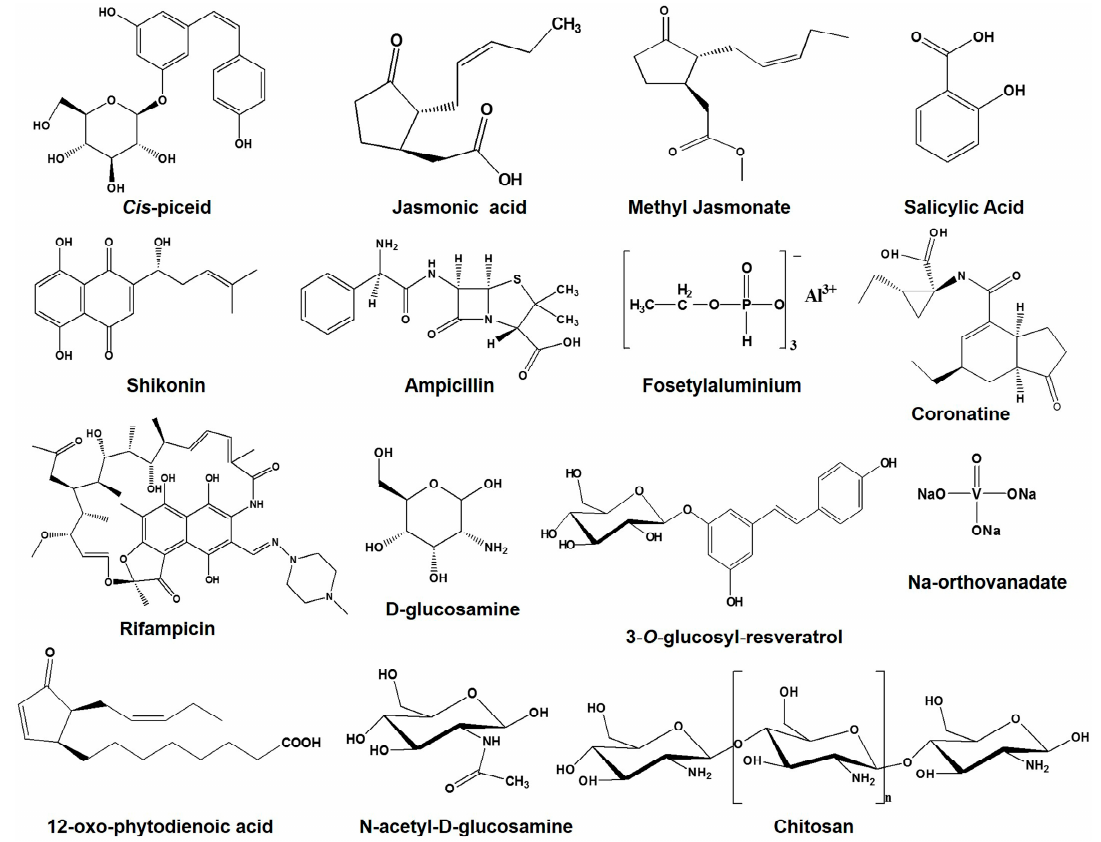
Figure 2. Molecular structure of different compounds or elicitors mentioned in this review.